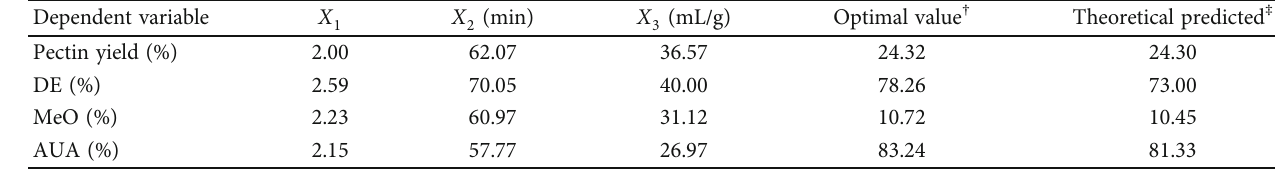
Table 4: Optimized responses and theoretical optimum.